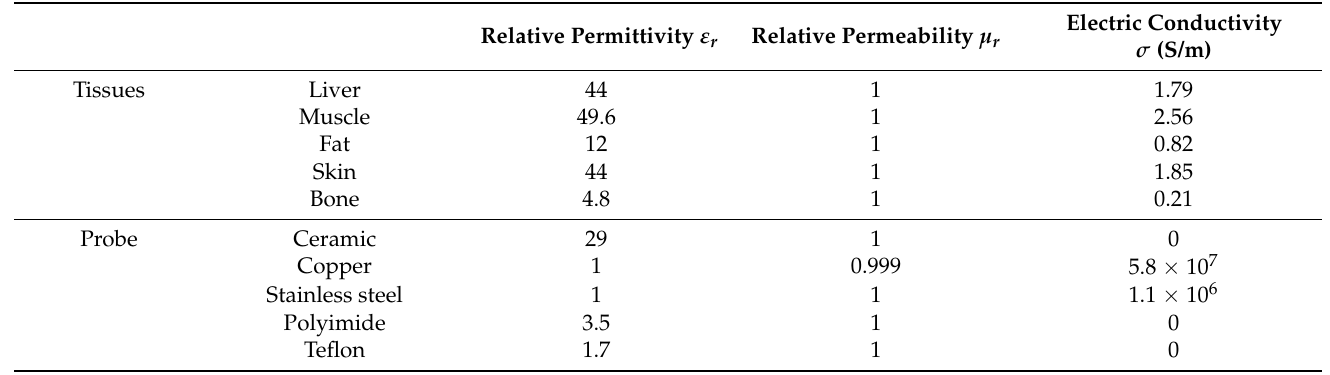
Table 2. Electromagnetic properties for a frequency of 2.45 GHz